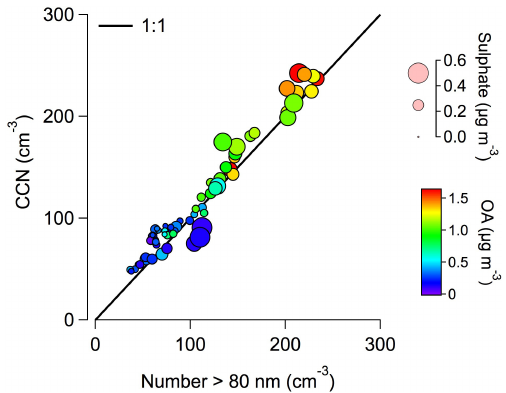
Figure 7. Correlation between the number of particles greater than 80nm ( N > 80 , measured by the UHSAS) and the cloud condensa- tion nuclei (CCN) concentration at 0.6% supersaturation, below 1km, during the case study period. Data are coloured by organic aerosol loading and point size corresponds to sulfate